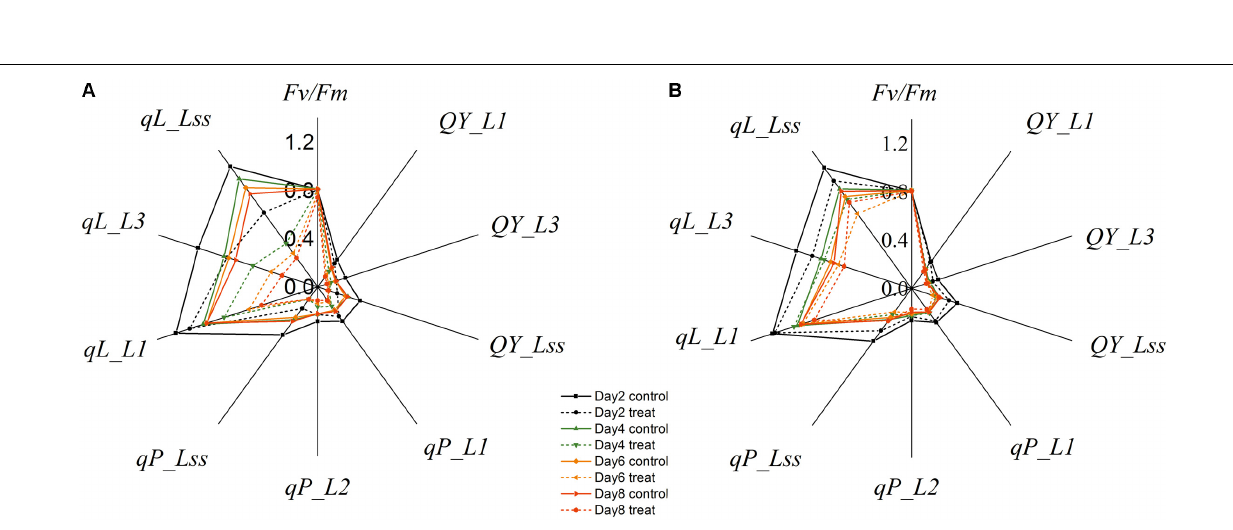
Frontiers in Plant Science |